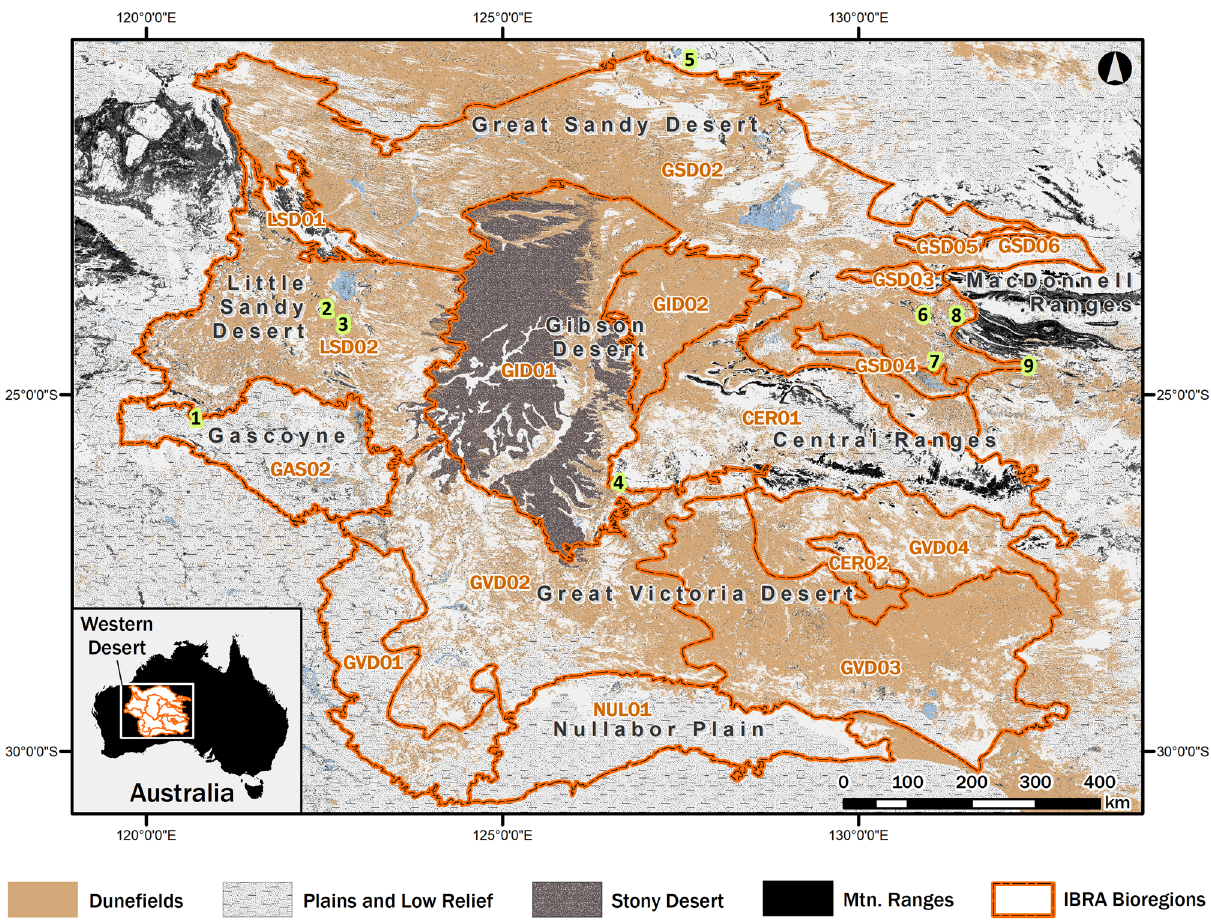
Figure 1. Location of the Western Desert in relation to continental Australia. The bioregional boundaries of the Interim Biogeographic Regionalisation for Australia (IBRA) 23 subregions are shown in relation to major land systems and desert regions. The code keys to IBRA subregions are: CER01-Central Ranges (Mann-Musgrave), CER02-Central Ranges (Watarru), GAS02-Gascoyne (Carnegie), GID01-Gibson Desert (Lateritic), GID02- Gibson Desert (Dunefield), GSD02-Great Sandy Desert (MacKay), GSD03-Great Sandy Desert (Ehernberg), GSD04-Great Sandy Desert (Amadeus), GSD05-Great Sandy Desert (Lake Bennett), GSD06-Great Sandy Desert (Lake Lewis), GVD01-Great Victoria Desert (Shield), GVD02-Great Victoria Desert (Central), GVD03-Great Victoria Desert (Maralinga), GVD04-Great Victoria Desert (Kintore), LSD01-Little Sandy Desert (Rudall), LSD02-Little Sandy Desert (Trainor), and NUL01-Nullarbor (Carlisle). Excavated rockshelter sites with long archaeological sequences (lime green) include: (1) Karnatukul (Serpent’s Glen), (2) Bushturkey-3, (3) Kaalpi, (4) Puntuntjarpa, (5) Parnkupirti, (6) Puritjarra, (7) Glen Thirsty, (8) Tjungkupu, and (9) Kulpi Mara. Map created in ESRI ArcGIS Desktop 10.5.1 (https:// deskt op. arcgis. com). Vector layers adapted from Creative Commons datasets (GEODATA Topo 250 K Series 3, Atlas of Australian Soils, and IBRA Version 7 Subregions) available at https:// data. gov. au. Montane upland layer based on terrain ruggedness raster (see “Methods”